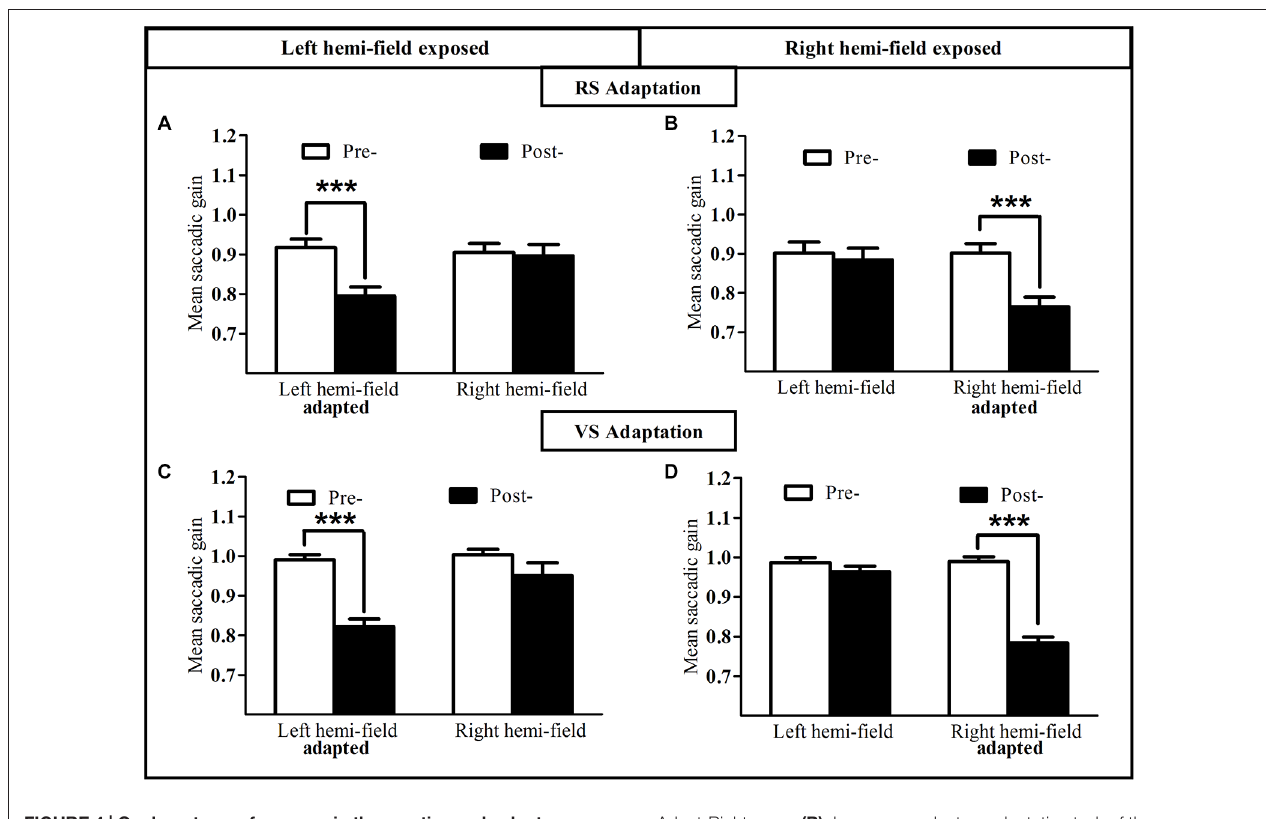
FIGURE 4 | Oculomotor performance in the reactive and voluntary saccade conditions of Experiment I. Mean saccadic gain are shown in the pre- (white bars) and post-exposure phases (black bars). Upper row: reactive adaptation task of the Adapt-Left group (A) and